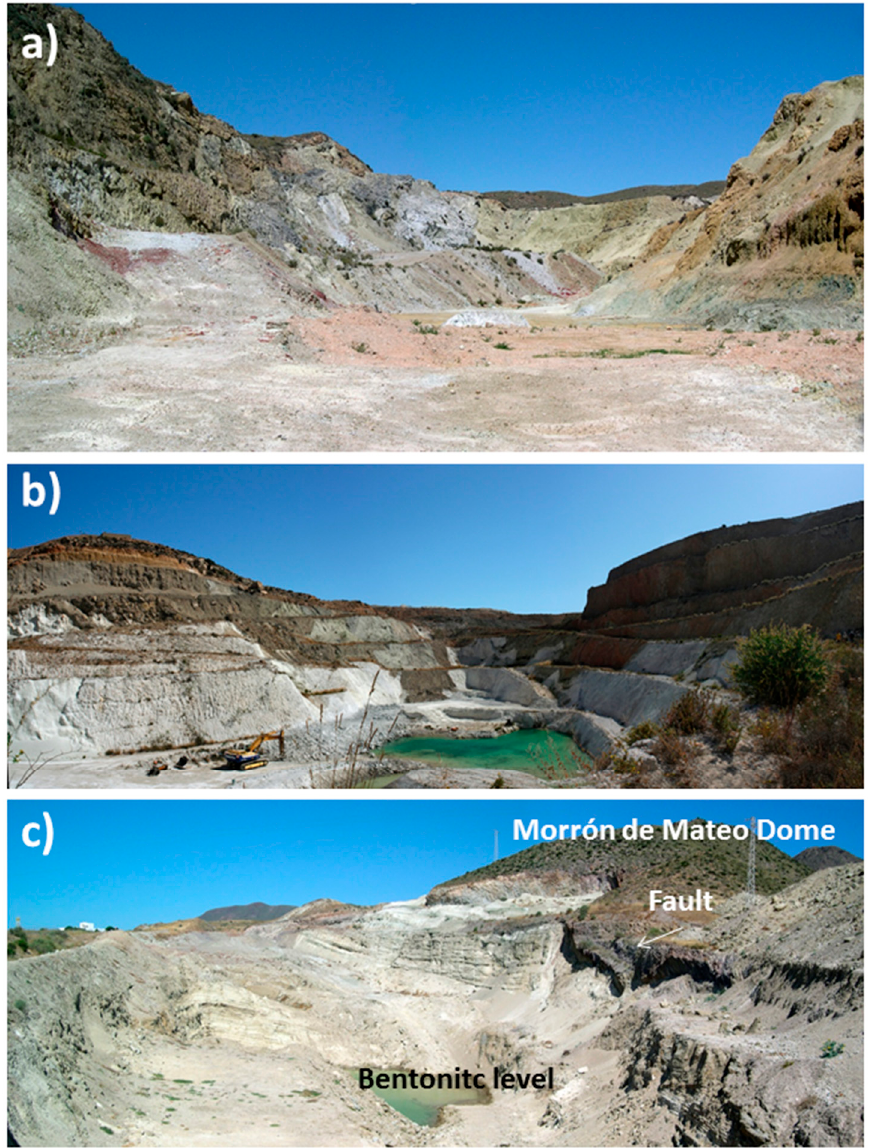
Figure 8. Representative images from the Cabo de Gata quarries. ( a ) The Cortijo de Archidona quarry; ( b ) the Los Trancos quarry; and ( c ) the Morrón de Mateo quarry. Note the dome intrusion in the Morrón de Mateo picture and the fault between the dome and the bentonitic levels.